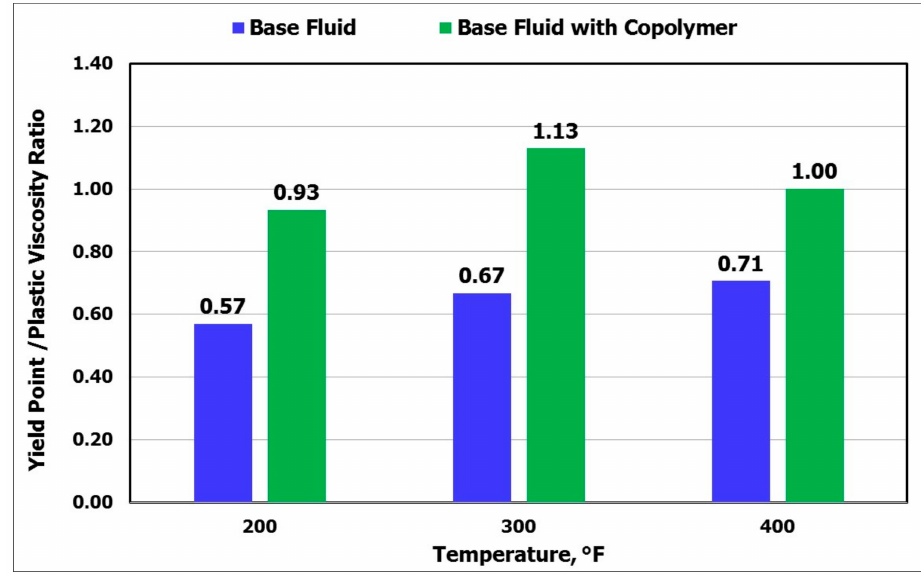
Figure 9. Effect of temperature on the yield point/plastic viscosity ratio.